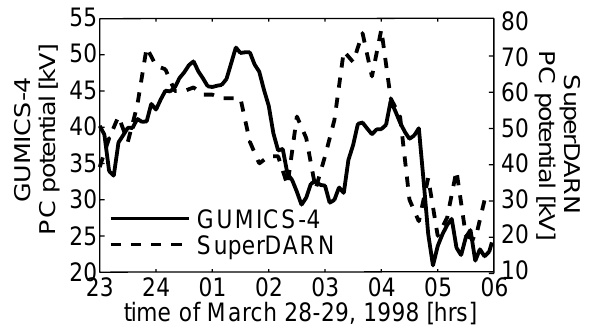
Fig. 12. GUMICS-4 (SuperDARN) polar cap potential on the left (right) axis. Due to insufficient radar data coverage, the Super- DARN may underestimate the polar cap potential during the first